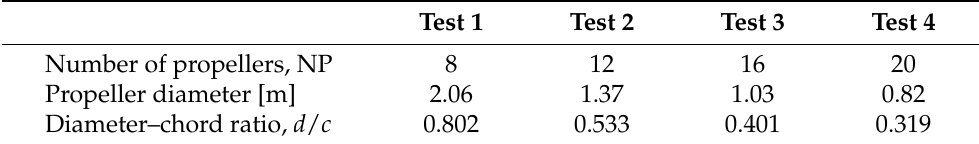
Table 1. Distributed Electric Propulsion Configurations.